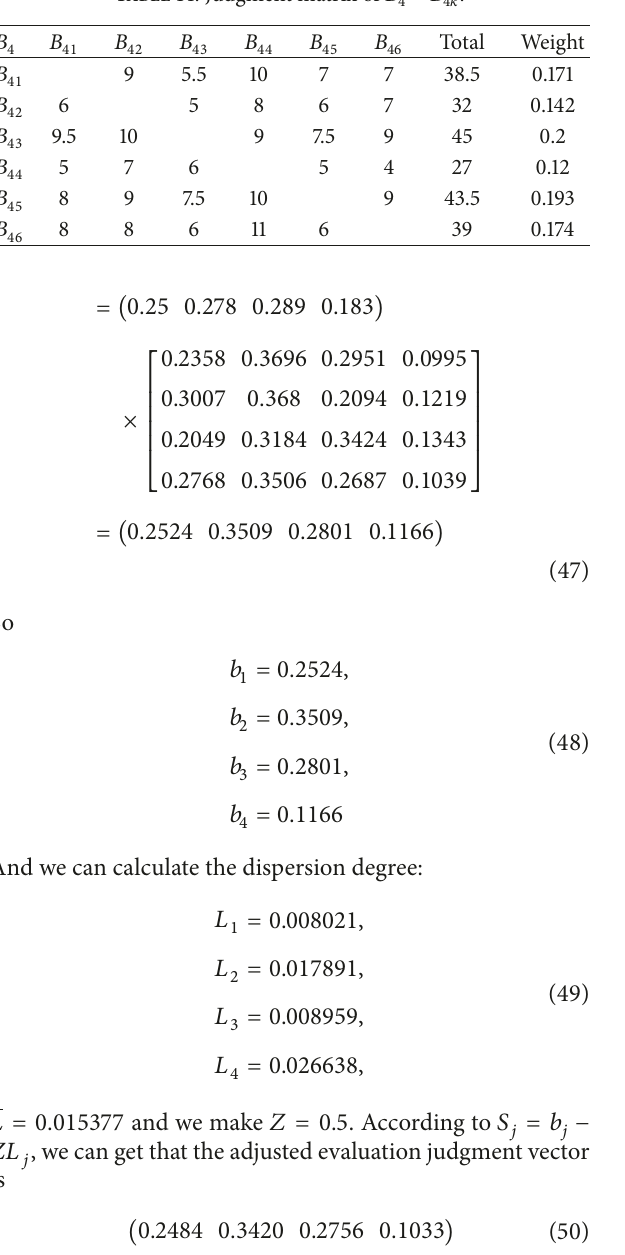
Table 14: Judgment matrix of 𝐵 4 − 𝐵 4𝑘 .